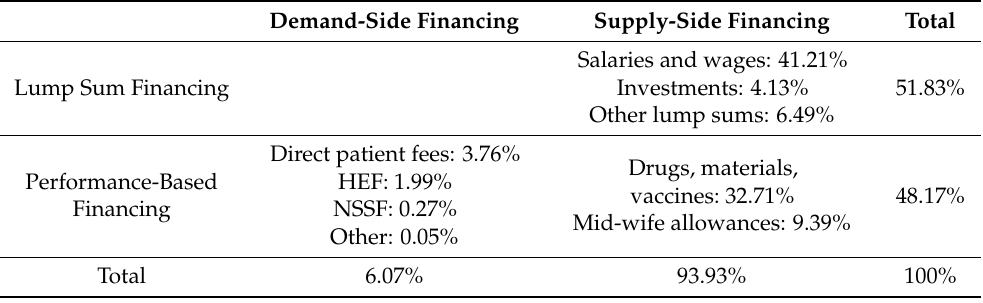
Figure 3. Income categories. Source: own. Table 2. Sources of funding of public health centers in Kampong Thom and Kampot Provinces (percentage of total income). Source: